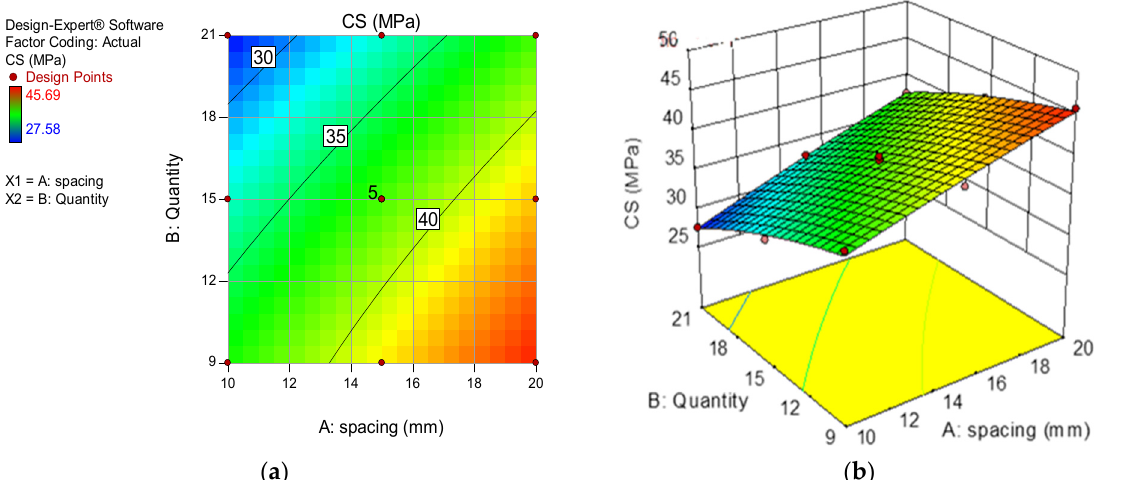
Figure 12. ( a ) Two ‐ dimensional contour plot; ( b ) Three ‐ dimensional response surface diagram for CS model.